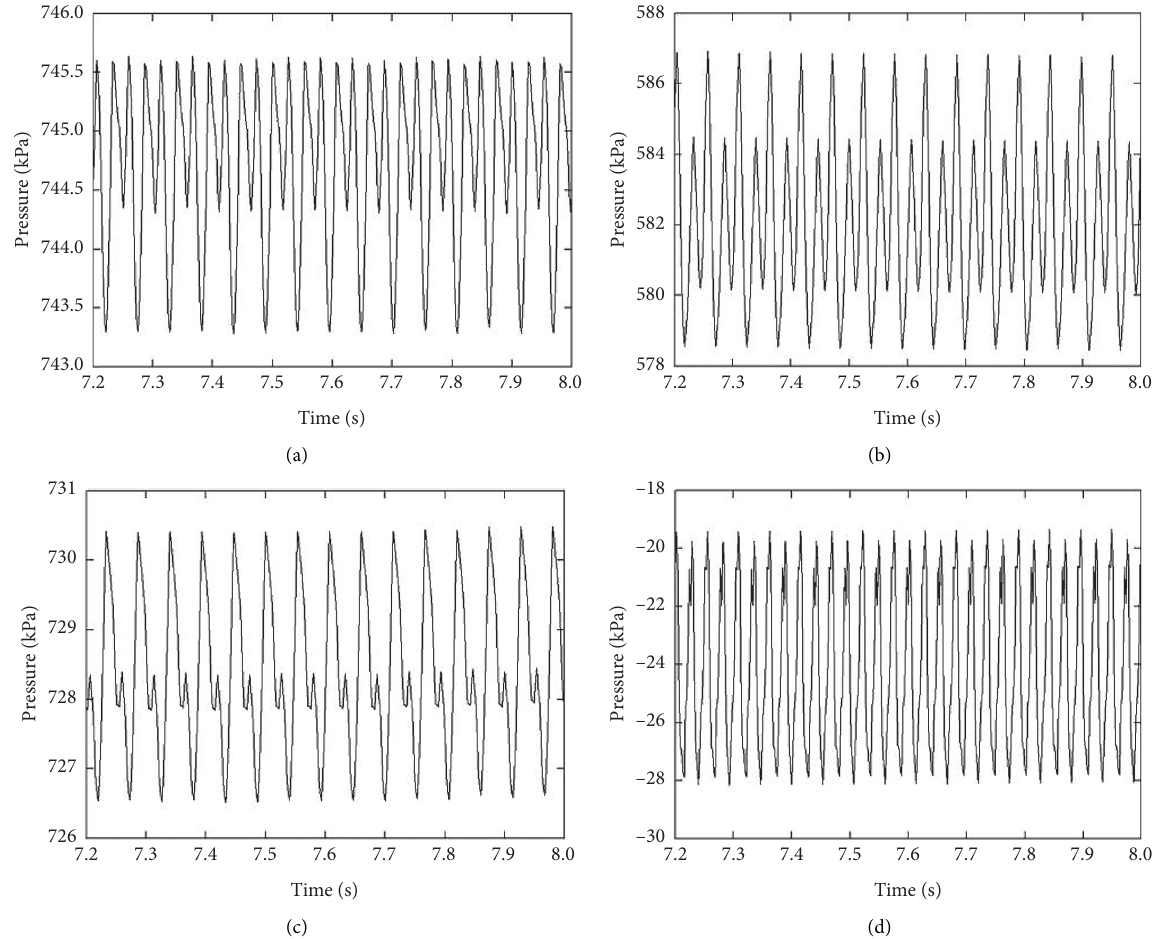
Figure 10: Numerical simulation results of time history of pressure pulsation at different positions in the fluid domain. (a) Measuring point F01 at head cover. (b) Measuring point F02 at the vaneless region. (c) Measuring point F03 at the bottom ring. (d) Measuring point F04 at 0.3D of the draft